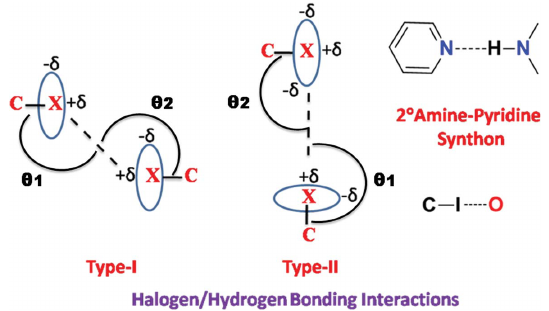
Figure 13 Halogen-bonding interactions and hydrogen-bonding synthons in the present